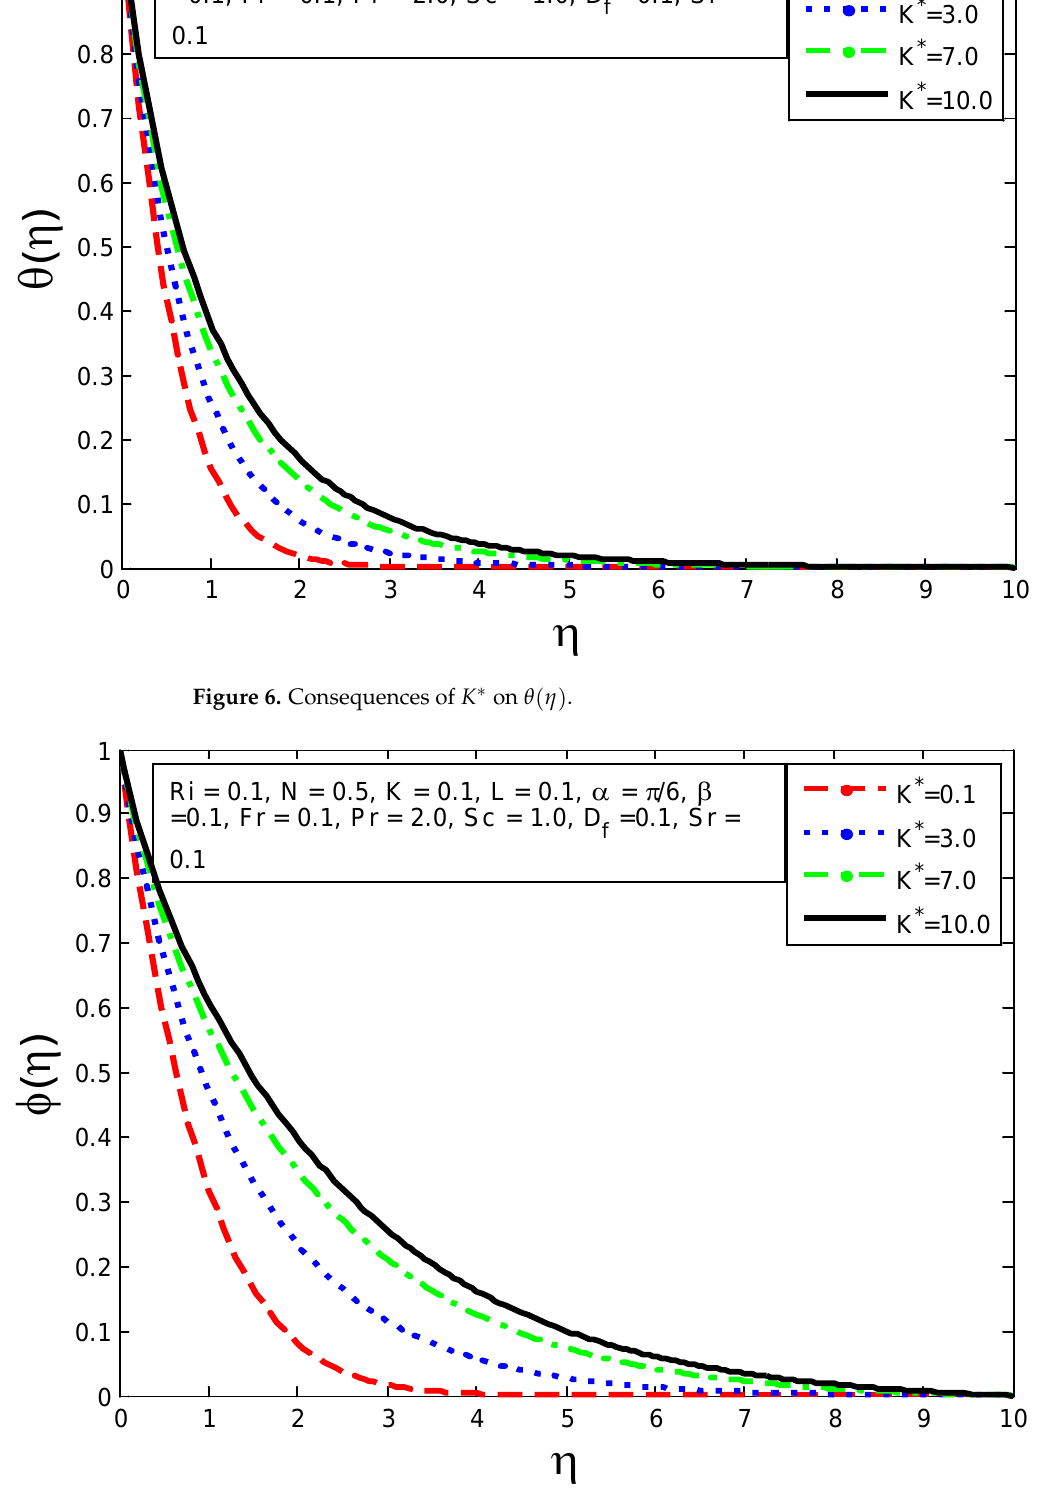
Figure 7. Consequences of K ∗ on φ ( η )